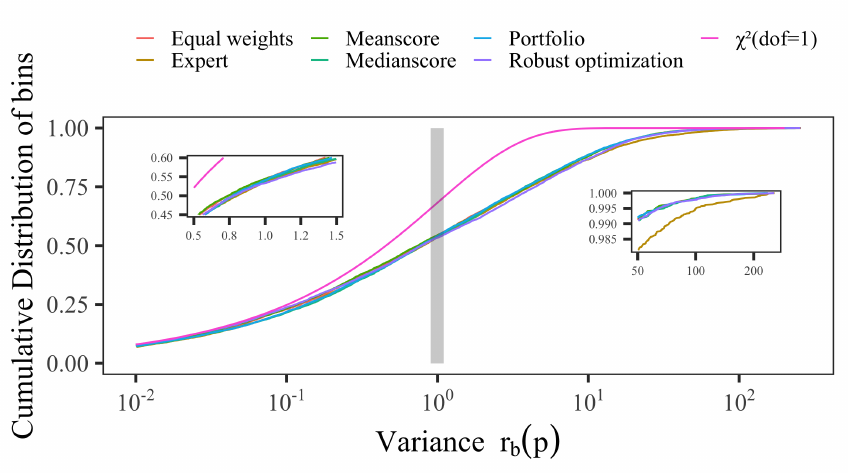
Figure 2: Cumulative distribution function (CDF) of all bins (y-axis) in the A14 dataset at different bands of variance levels (x-axis) given by r and the theoretical χ 2 distribution with one degree of